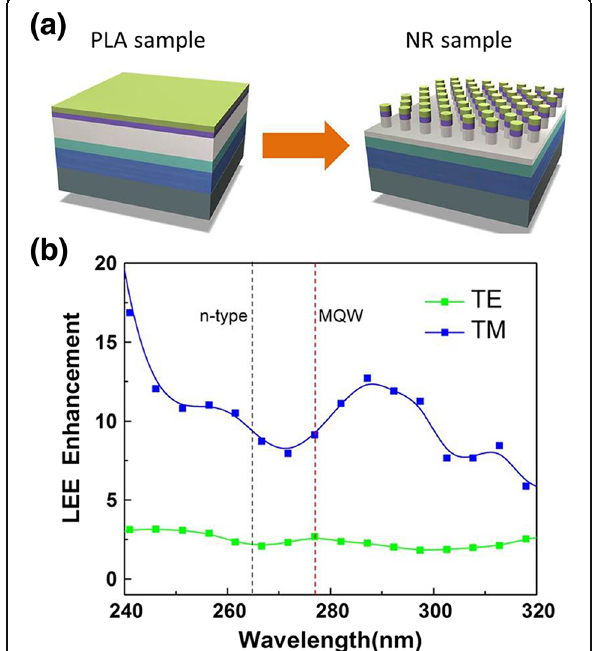
Fig. 4 a The structure diagram of PLA and NR sample. b The LEE enhancement of NR sample compared with PLA sample at TE and TM polarization state calculated by FDTD simulation. The black and red dashed lines correspond to the emission wavelength of n-type AlGaN layer and AlGaN MQWs,